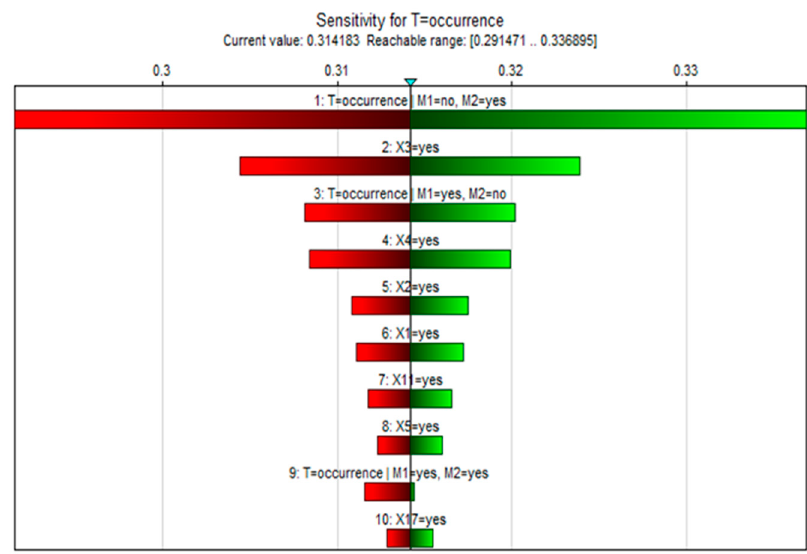
Figure 11. Node sensitivity analysis.